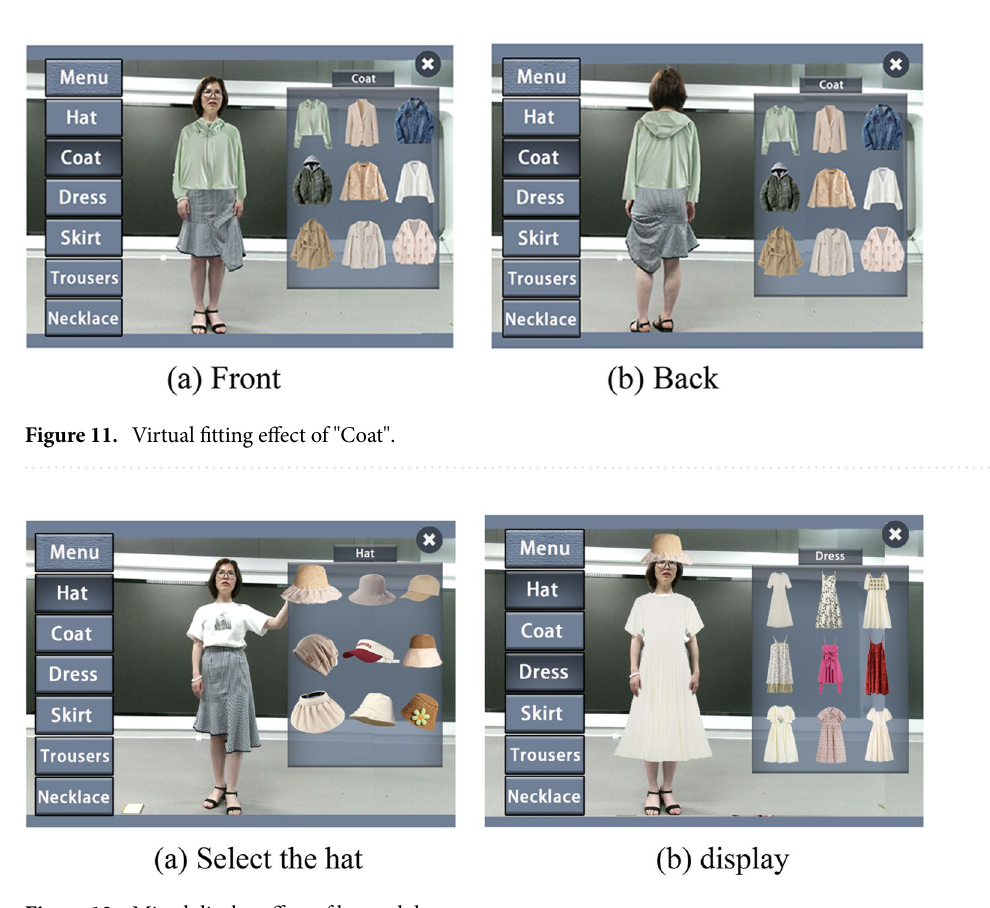
Figure 12. Mixed display effect of hat and